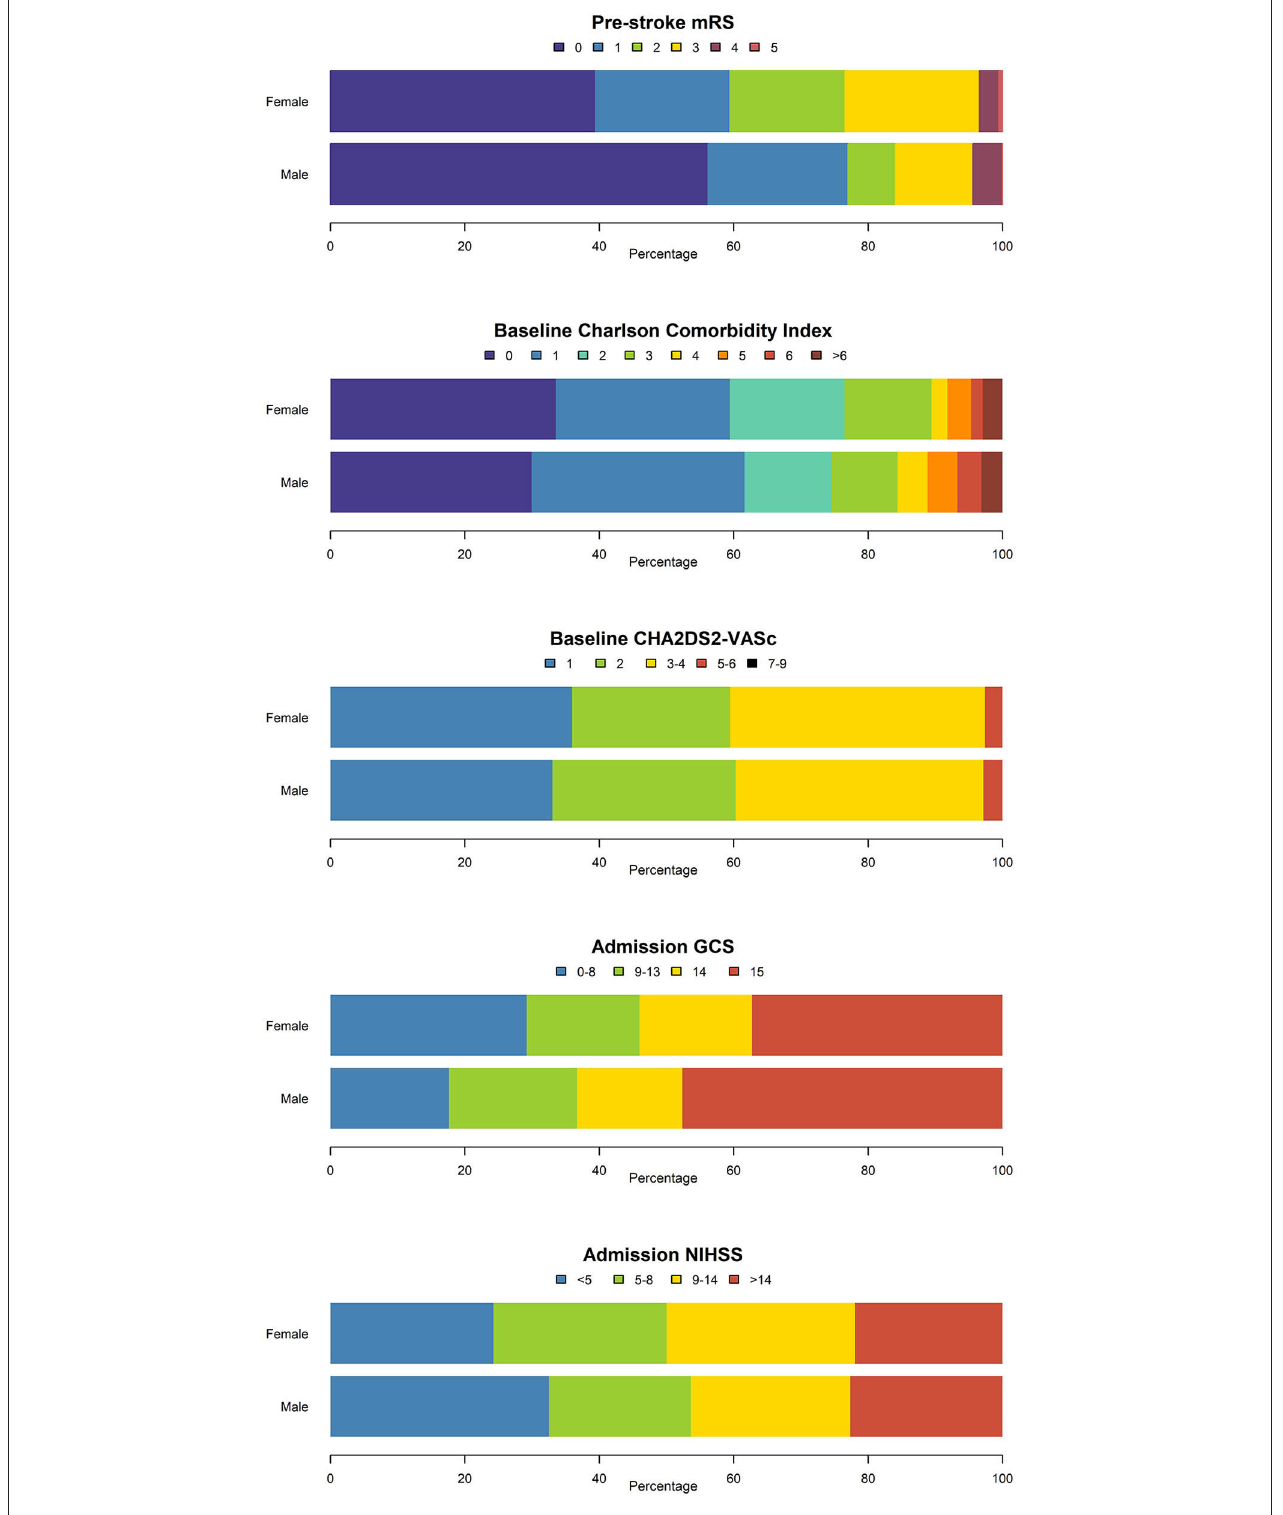
FIGURE 4 | Disability-, comorbidity-, and stroke-severity scores in men and women with OAC-ICH. mRS, modified Rankin Scale; GCS, Glasgow Coma Scale; NIHSS, National Institutes of Health Stroke Scale.